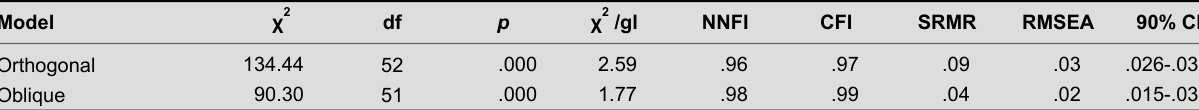
Fit Indexes for the Orthogonal and Oblique Bi-Factorial